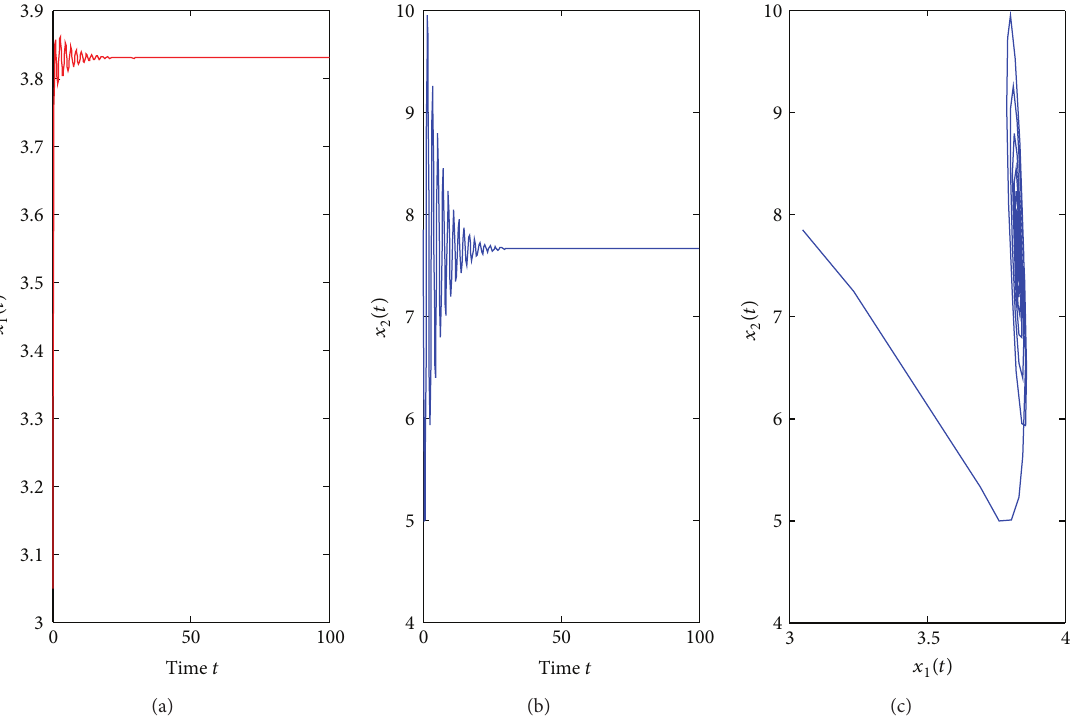
Figure 3: 𝐸 ∗ is asymptotically stable for 𝜏 2 = 0.450 < 𝜏 20 = 0.4912 .